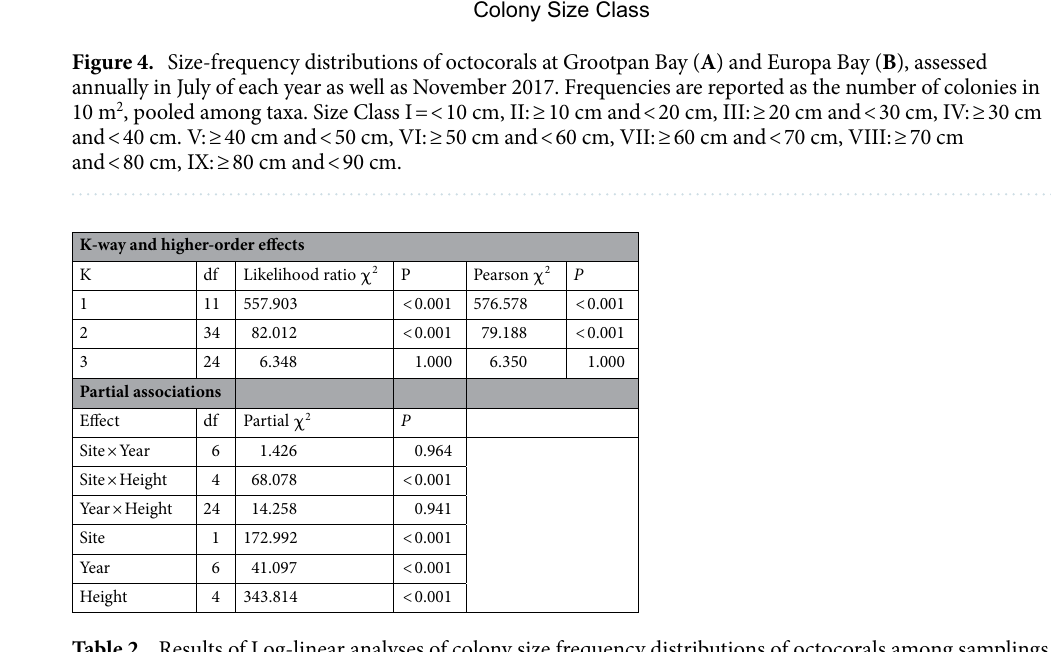
Table 2. Results of Log-linear analyses of colony size frequency distributions of octocorals among samplings (7 samplings in 6 years) and sites (Grootpan Bay and Europa Bay). First order effects of site, year, and height (size classes: I < 10 cm, II ≥ 10 and < 20 cm, III ≥ 20 and < 40 cm, IV ≥ 40 and < 60, and V ≥ 60 cm) indicate that the number of colonies differed between sites, between years, and in the different size classes. The 3-way effect in the upper section is the Site x Year x Height